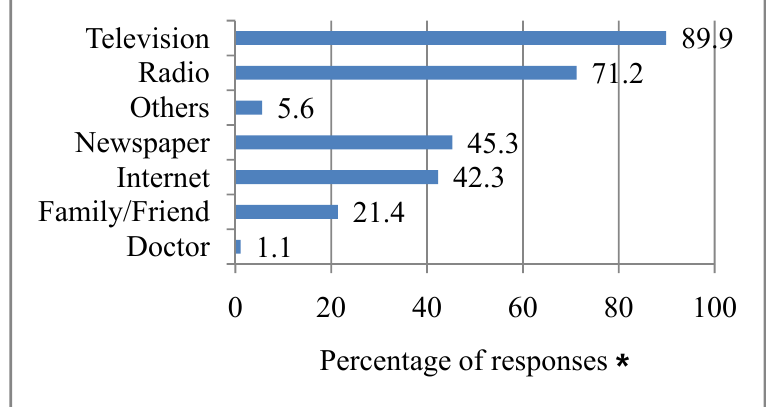
Figure 1. Sources of information about heat waves. Q1: Where do you normally get information about heat waves? (multiple